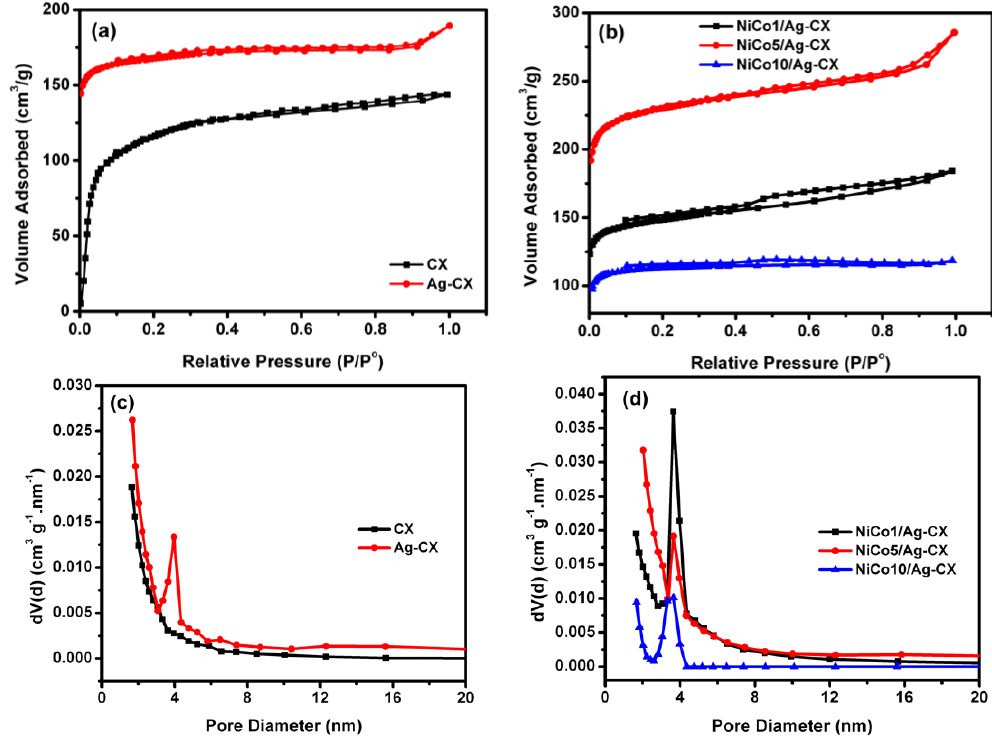
Figure 1. N 2 adsorption–desorption isotherms of ( a ) CX and Ag-CX, ( b ) NiCo1 / Ag-CX, NiCo5 / Ag-CX, and NiCo10 / Ag-CX. BJH Pore size distributions for ( c ) CX and Ag-CX, ( d ) NiCo1 / Ag-CX, NiCo5 / Ag-CX, and NiCo10 / Ag-CX. Table 1. Textural characteristics of the